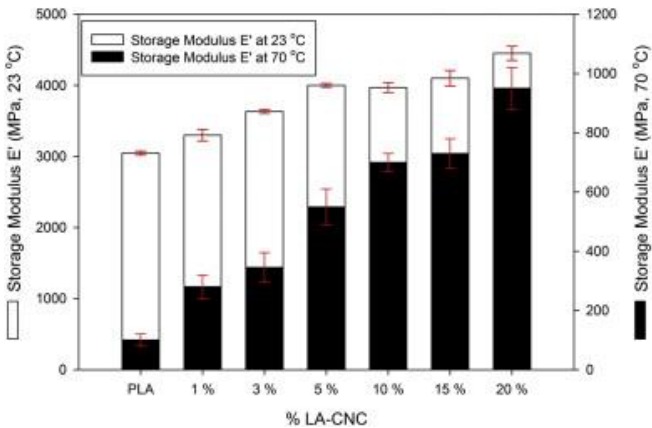
Figure 9. Storage modulus for PLA/LA-CNC nanocomposites at 23 and 70 °C. Reprinted with permission from [52]. permission from